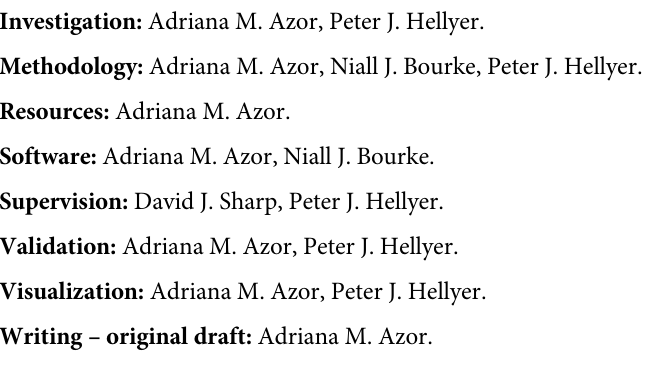
S1 Fig. Example of segmentation of whole tracts. Tracts are color-coded; Red: splenium of corpus callosum, Orange: body of corpus callosum, Green: genu of corpus callosum, Light Blue: corticospinal left and right, Dark Blue: Middle Cerebellar Peduncle. (TIF) S2 Fig. Repeatability of measures across visits for boundaries of the WM. 3D correlation plot of mean FA value and number of voxels for all three visits per tract, per subject. Each color represents a region of the boundary of the WM.